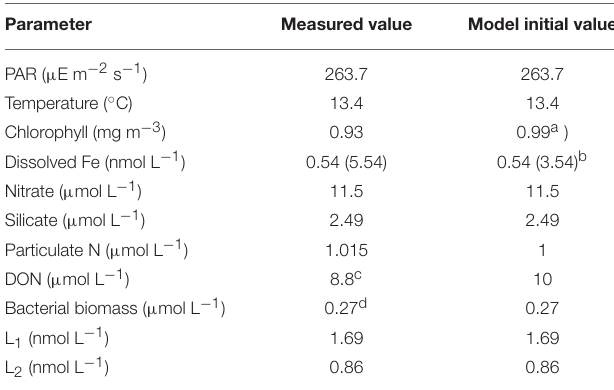
TABLE 1 | Ancillary measurements made in the water column as part of the CCE-LTER program for biological experiment 1 and used as initial parameters in the